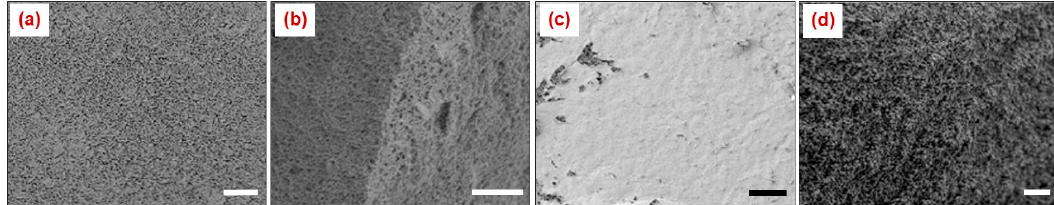
Figure 16. SEM images of outer surfaces ( a , c ) and inner surfaces of skins and bulk morphologies ( b , d ) of RF foam aerogel beads obtained via reactions catalyzed by triethylamine (a, b: 0.39% w/w), or tri(n-butyl)amine (c, d: 0.039% w/w). Scale bar: 2 μ m. Reprinted by permission of Taylor & Francis Ltd., http://www.tandfonline.com , Ref. [111].